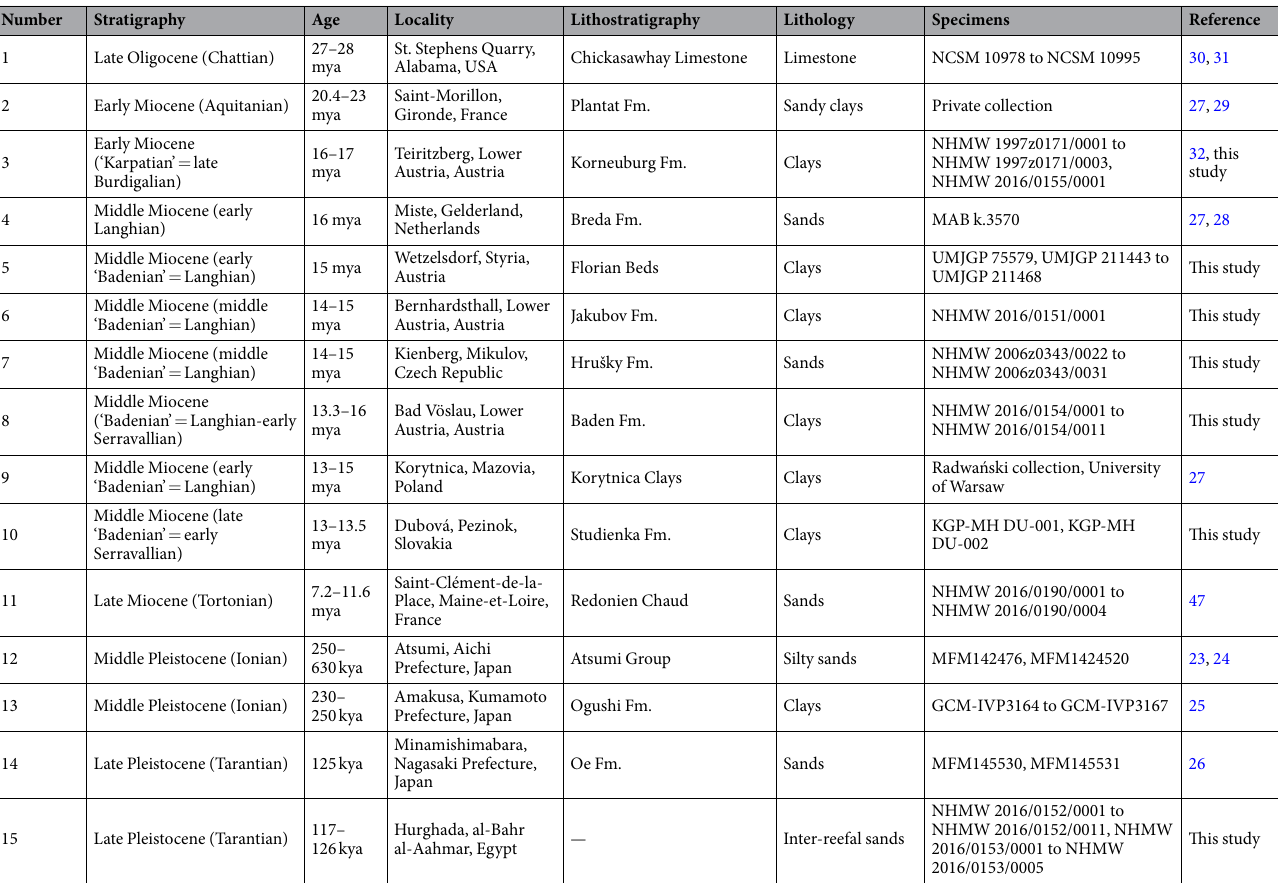
Table 1. Fossil specimens used in the present study. Material listed in geochronological order. The consecutive numbers correspond to localities depicted in Fig. 2. GCM = Goshoura Cretaceous Museum,